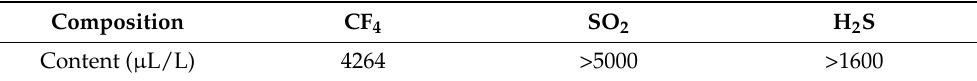
Table 6. Test results of SF 6 gas composition of the 550 kV circuit breaker.